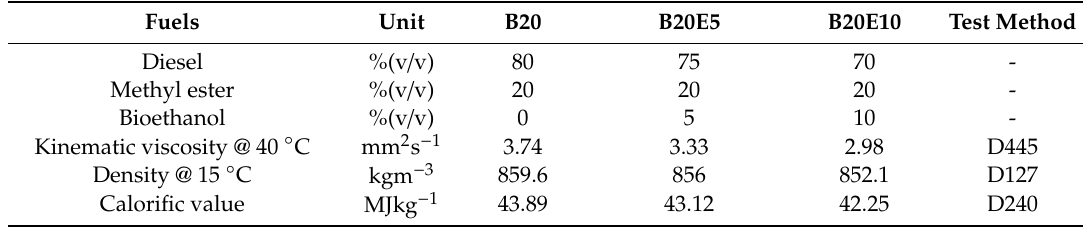
Table 2. The composition and fuel properties of tested